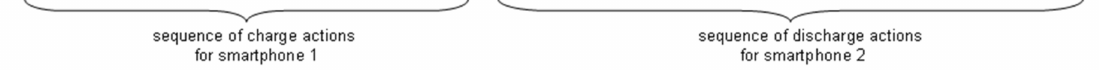
Figure 5. Encoded solution for an example